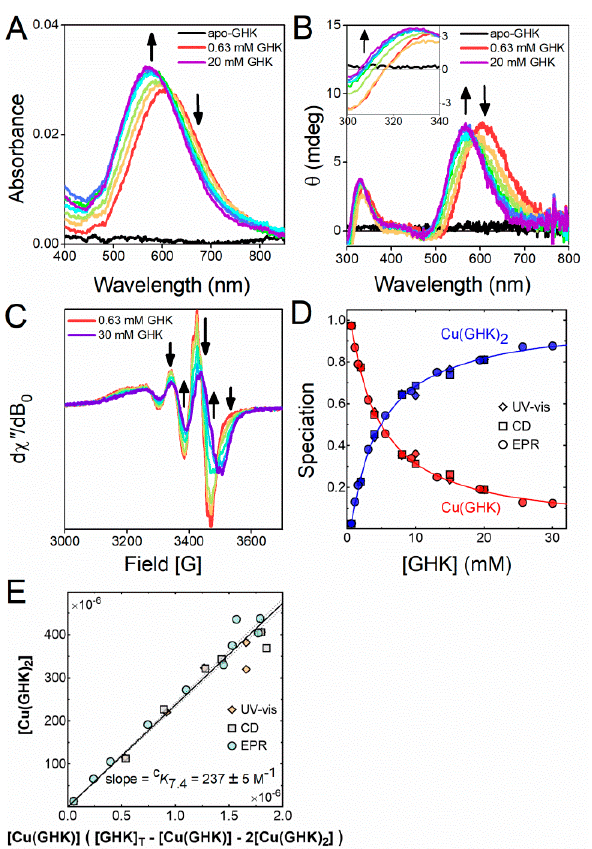
Figure 1. The conditional Cu(II) binding constant c K 7.4 = [Cu(GHK) 2 ]/([Cu(GHK)][GHK]). ( A ) UV-vis, ( B ) circular dichroism (CD), and ( C ) electron paramagnetic resonance (EPR) spectra of Cu/GHK 0.5: n (0.63 ≤ n ≤ 30 mM) at pH 7.4, 25 °C. ( D ) Speciation diagram obtained by decomposition of all UV-vis (diamonds), CD (squares), and EPR (circles) spectra (Figures S4–S6). The solid lines were calculated using the binding constant derived from ( E ) and log c K 1 = [Cu(GHK)]/([GHK][Cu]) = 12.62 derived from potentiometry. ( E ) Determination of the binding constant c K 7.4 using least squares regression. The margin of error derives from the 95% confidence interval (dashed lines).